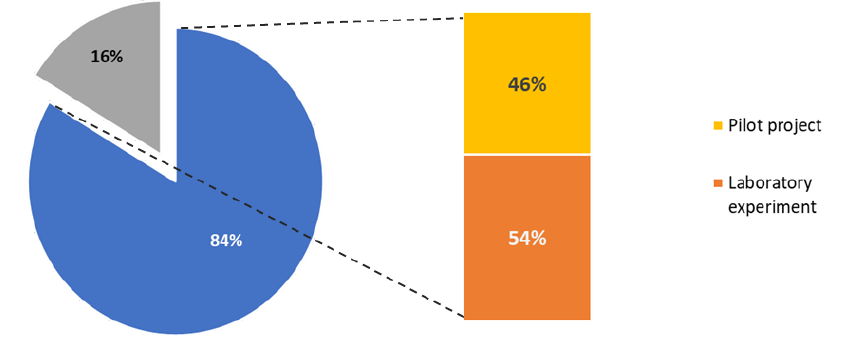
Figure 11. Industry adoption distribution of AR solutions 2010–2021.